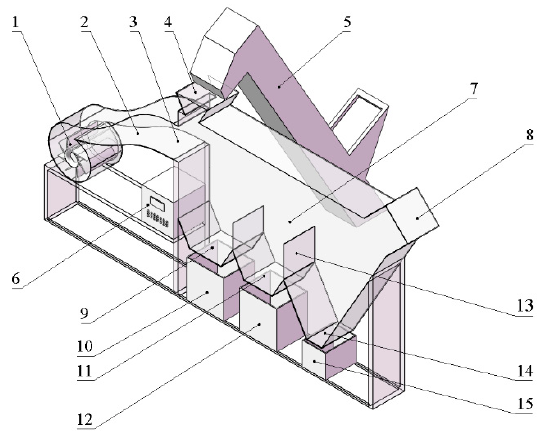
Figure 1. Schematic diagram of the structure of the safflower separation and cleaning device. 1. Blower; 2. Ventilation pipe; 3. Inlet (airflow); 4. Feed hopper; 5. Feed device; 6. Control cabinet; 7. Separating chamber; 8. Dust collector; 9. Outlet 1; 10. Stones receiver; 11. Outlet 2; 12. Bonded Safflower petals receiver; 13. Baffle; 14. Outlet 3; 15. Safflower petals receiver.